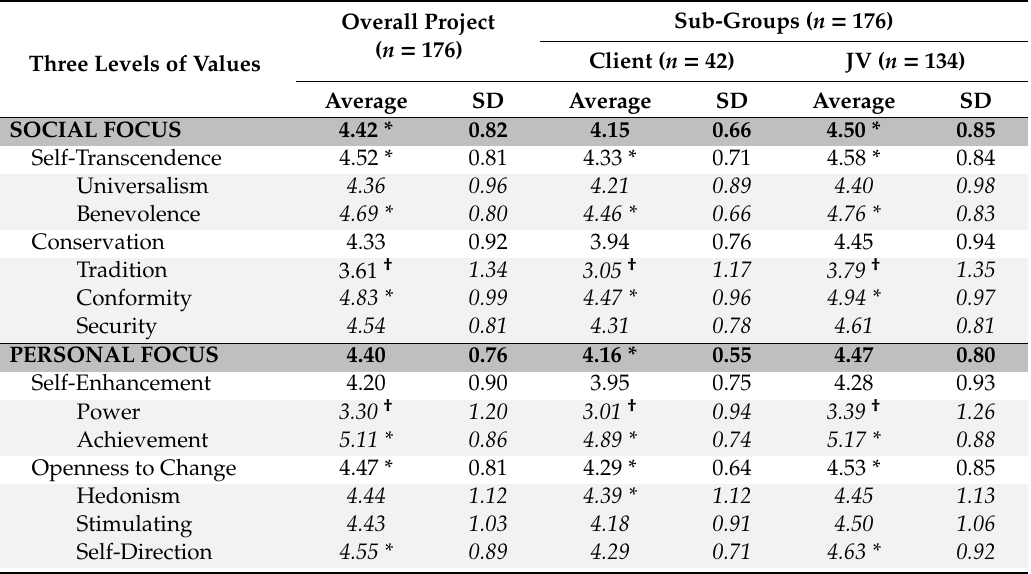
Table 3. Average value scores and standard deviations